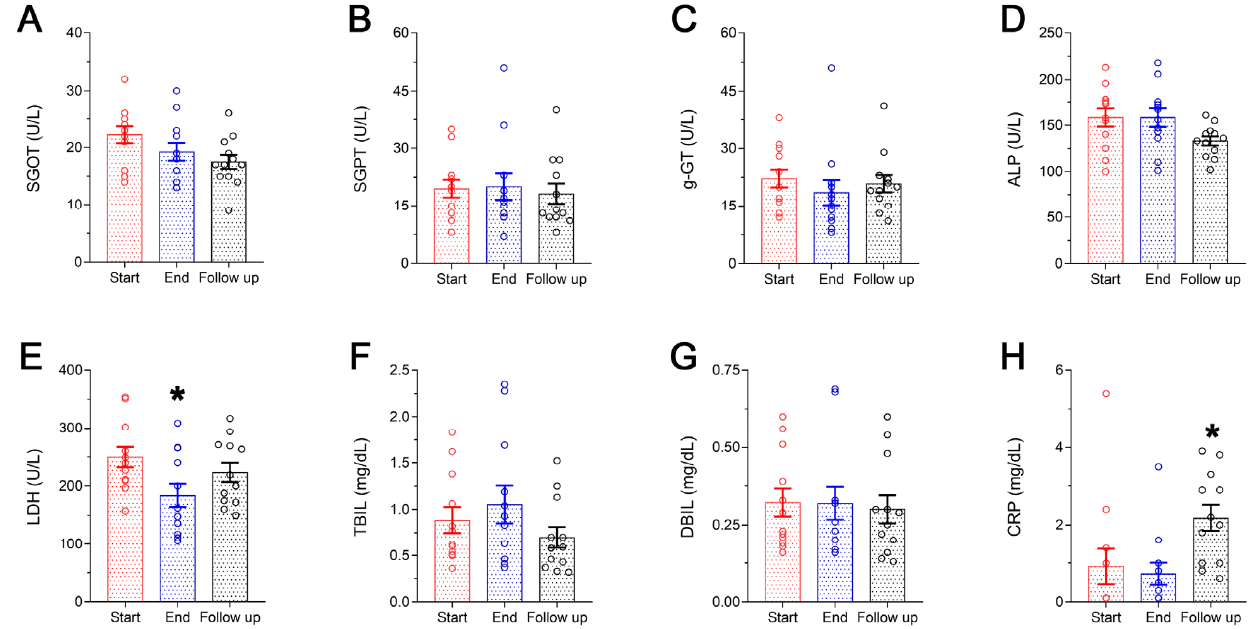
Figure 3. Liver function panel ( A – G ) and CRP levels ( H ) of the subjects during the study. A steep decrease in LDH was seen following Antiox-Plus supplementation ( p < 0.05), which was restored to pro-supplementation levels at follow-up ( E ). Liver function was not affected by Antiox-Plus treatment. The dots represent individual measures in 12 blood samples from healthy volunteers each time. Statistically significant difference from Start (Day 0) is shown as * ( p < 0.05).